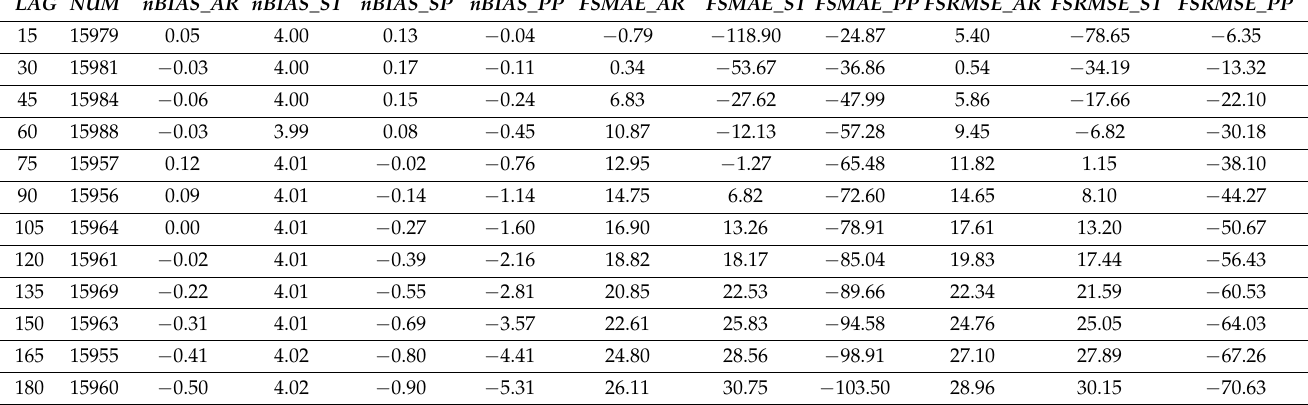
Table 7. Normalized BIAS and forecast skill related to MAE-FSMAE and RMSE-FSRMSE for plant P3 from 15 min up to three hours ahead.